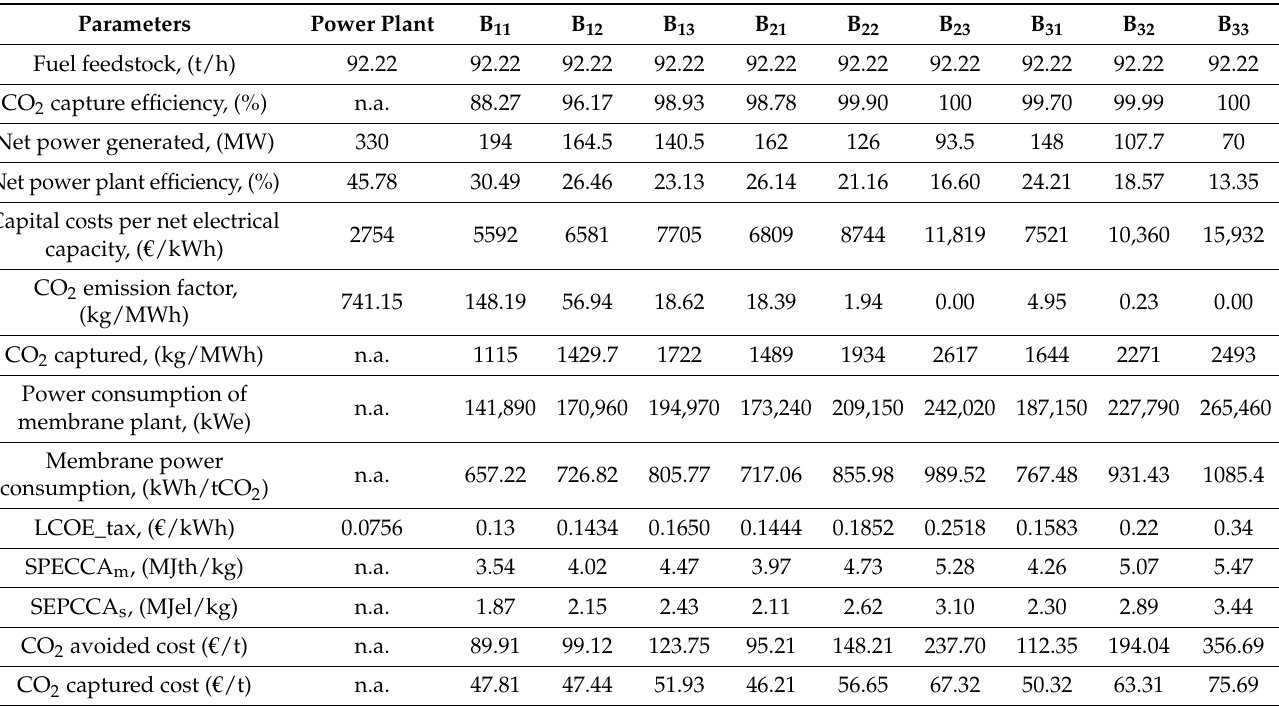
Table 13. The evaluation and economical assessment of the CFPP system with a single-stage of membrane technology (vacuum pump